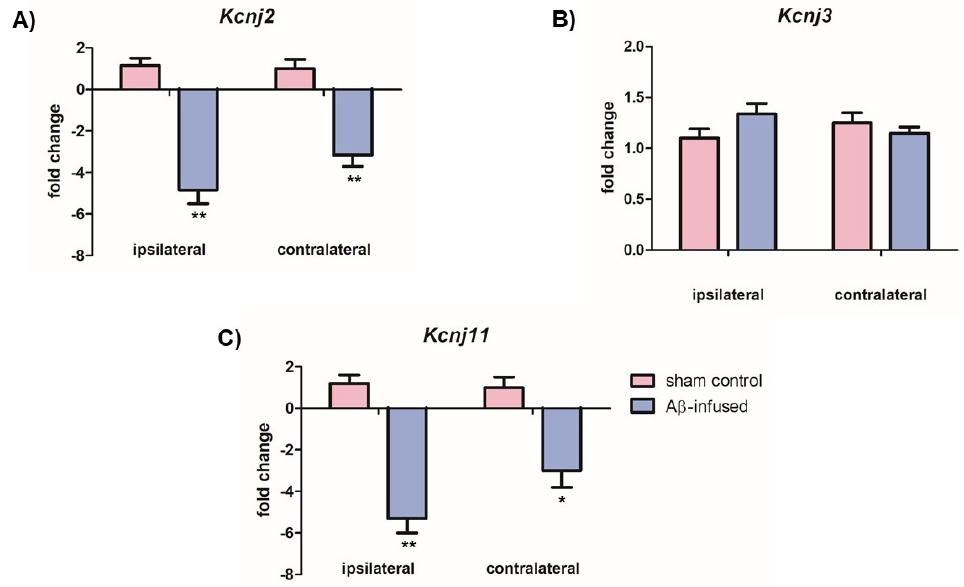
Figure 3. Relative mRNA levels of ( A ) Kcnj2 (Kir2.1), ( B ) Kcnj3 (Kir3.1), and ( C ) Kcnj11 (Kir6.2) in ipsilateral and contralateral hippocampi from both sham control and A β (1–42) -infused rat model. Data are expressed as fold change of mRNA levels normalized to the housekeeping control gene ( Gapdh ) and represent the mean ± SEM obtained in 3 independent experiments, n = 7 for each group, * p < 0.05, ** p < 0.01.